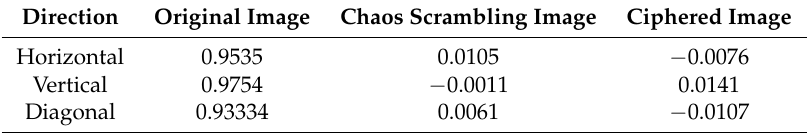
Table 2. Correlation coefficient of the original image and ciphered image.